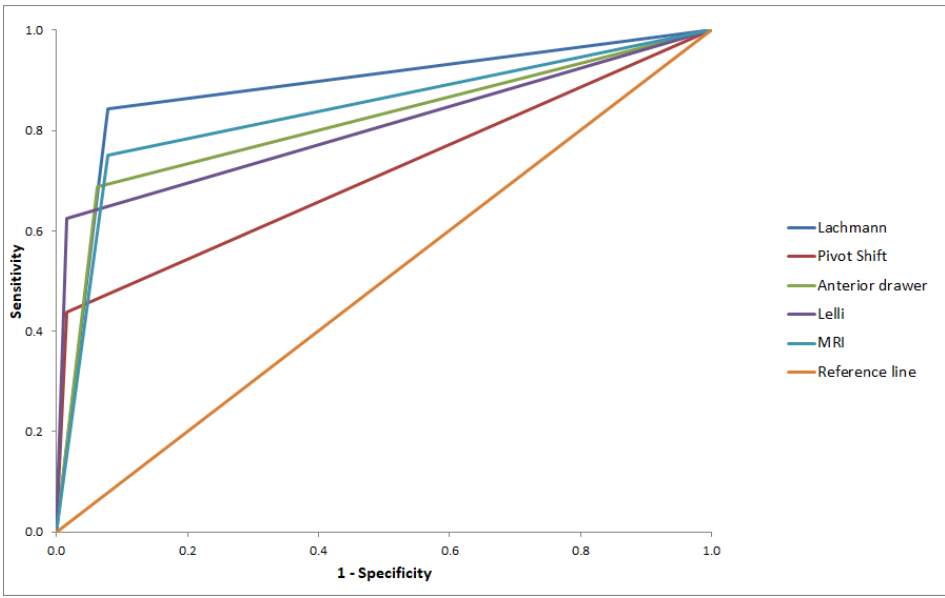
Figure 5. ROC curve describing the relation of sensitivity to specificity in diagnostic tests for the anterior cruciate ligament.